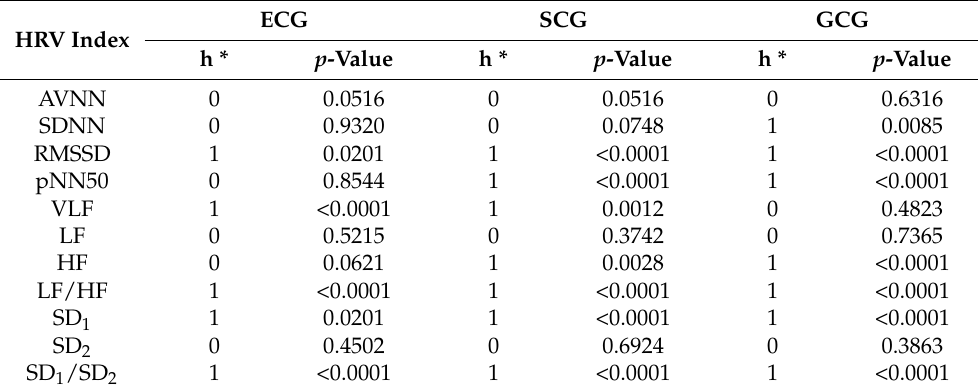
Table 5. Results of Student’s t -tests between healthy subjects and VHD subjects.